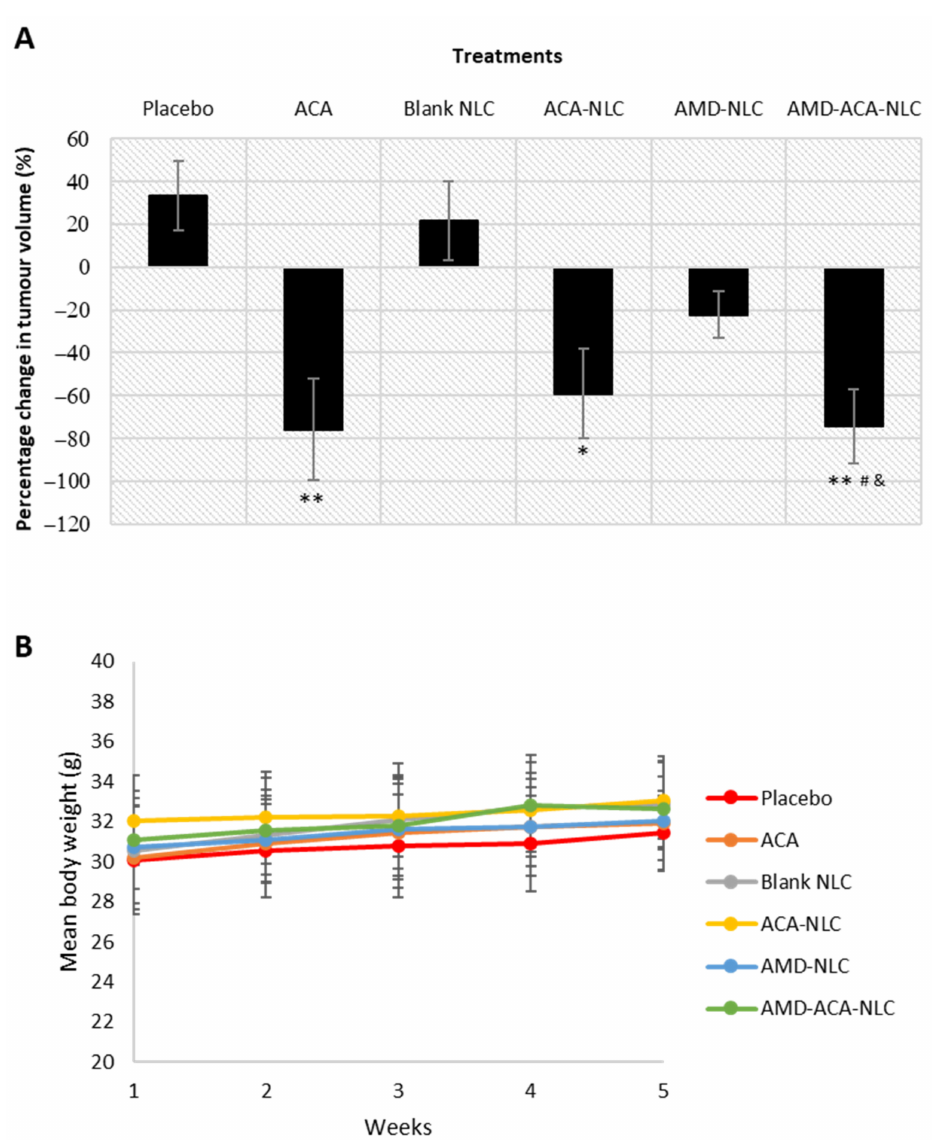
Figure 8. In vivo anti-tumor effects of placebo, ACA, blank NLC, ACA-NLC, AMD-NLC, and AMD-ACA-NLC treatments on NU / NU mice. ( A ) Percentage change in tumor volume at the end of the treatment. All data are shown as mean value ± SEM of four/five replicates per group. Statistically significant differences from placebo group are shown as * p < 0.05 and ** p < 0.1, while statistically significant differences from blank NLC and AMD-NLC are shown as # p < 0.05 and & p < 0.05, respectively. ( B ) Mean body weight of PC-3 induced NU/NU mice under various treatments over 28 days. All data are shown as mean value ± SD of five/six replicates per